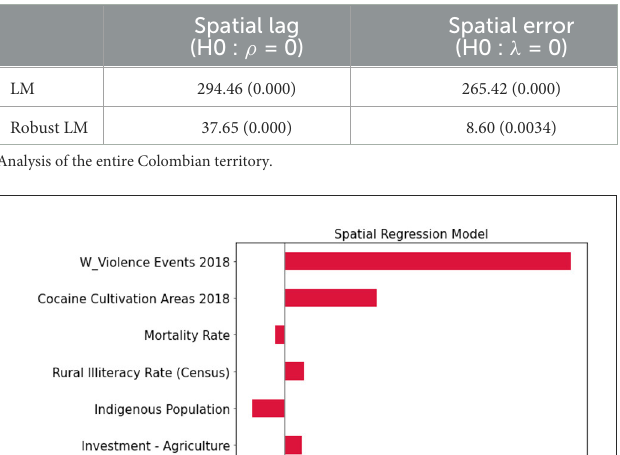
TABLE 2 Lagrange multiplier tests (the numbers in parentheses are p -values).